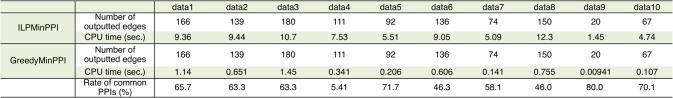
Performance evaluation of ILPMinPPI and GreedyMinPPI using synthetic data (syndata 2).